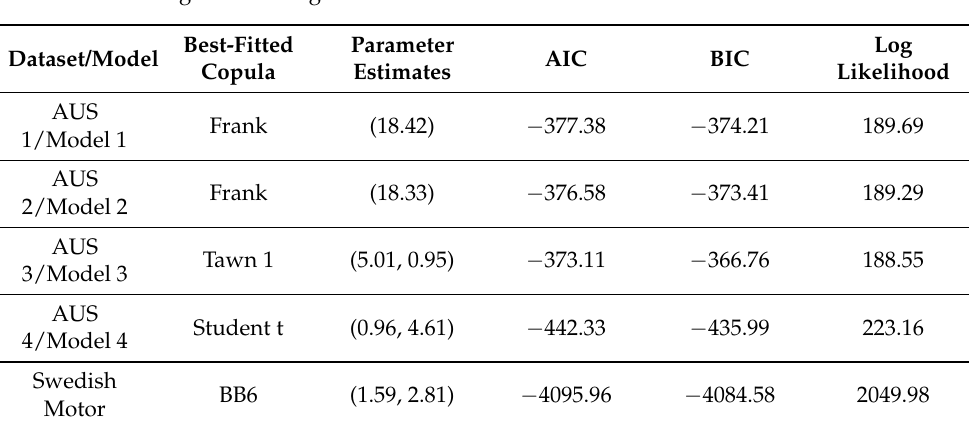
Table 3. Model diagnostics and goodness of fit statistics.